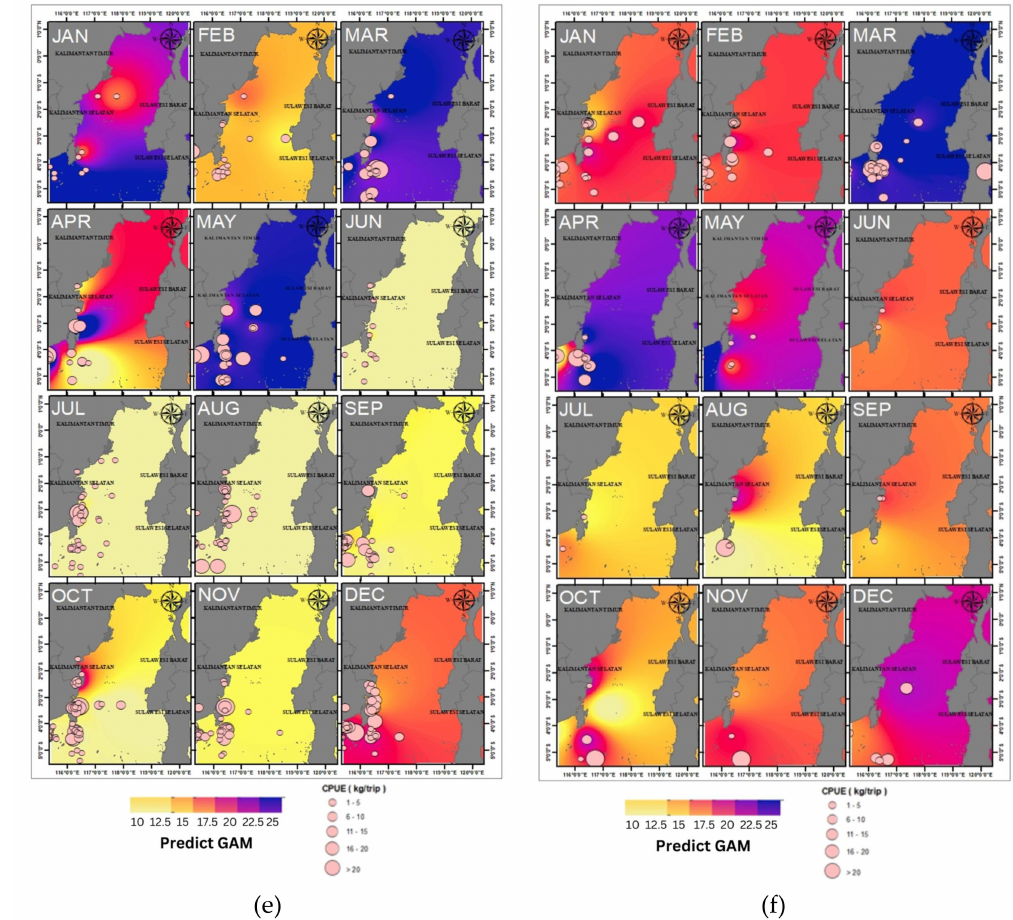
Figure 10. The potential fishing zone distribution of Eastern Little Tuna ( Euthynnus affinis ) in the Makassar Strait in ( a ) 2015, ( b ) 2016, ( c ) 2017, ( d ) 2018, ( e ) 2019, and ( f )